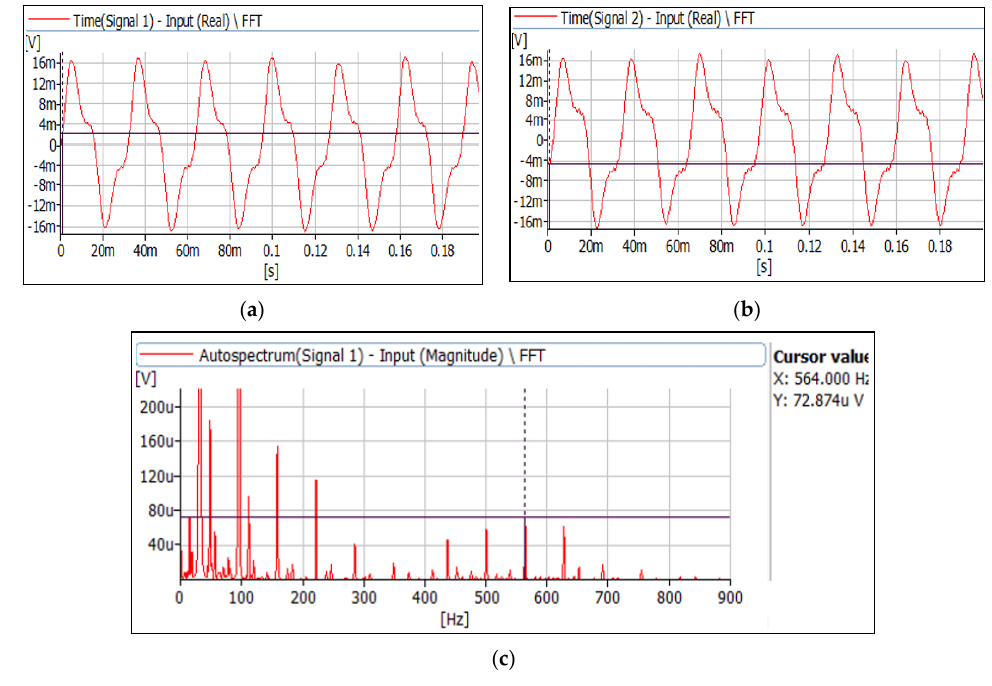
Figure 18. Signals measured by the flux sensors for balanced load: ( a ) emf measured in position 1, ( b ) emf measured in position 2, ( c ) signal spectrum delivered from flux sensor in position 1.